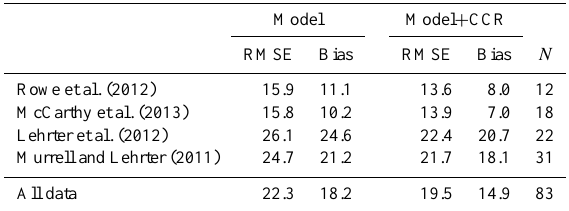
Simulated SOC within all four regions is plotted against Table 3. RMSE and bias (both in units of mmolO 2 m − 2 d − 1 ) be- bottom DO and compared with available observations in tween simulated median of sediment oxygen consumption (SOC) Fig. 7. Simulated SOC increases with increasing bottom and observed SOC. The simulation period ranged from 2004 to 2007, while observations from different sources were collected DO for oxygen concentrations below ∼ 80 mmol O 2 m − 3 and during longer period from 1991 to 2011. Bias was calculated as declines thereafter because of the temperature effect (SOC model median minus observation with same bottom dissolved oxy- halves for each temperature decrease of 10 ◦ C). SOC obser- gen (DO) concentration. N is the number of observations available vations from different sources vary over a large range from for each category. upper range of the available observations. Model bias in Ta- Model Model + CCR ble 3 indicates that the median of simulated SOC overesti- RMSE Bias RMSE Bias N mates the observed SOC when combining all sources Rowe et al. (2012)